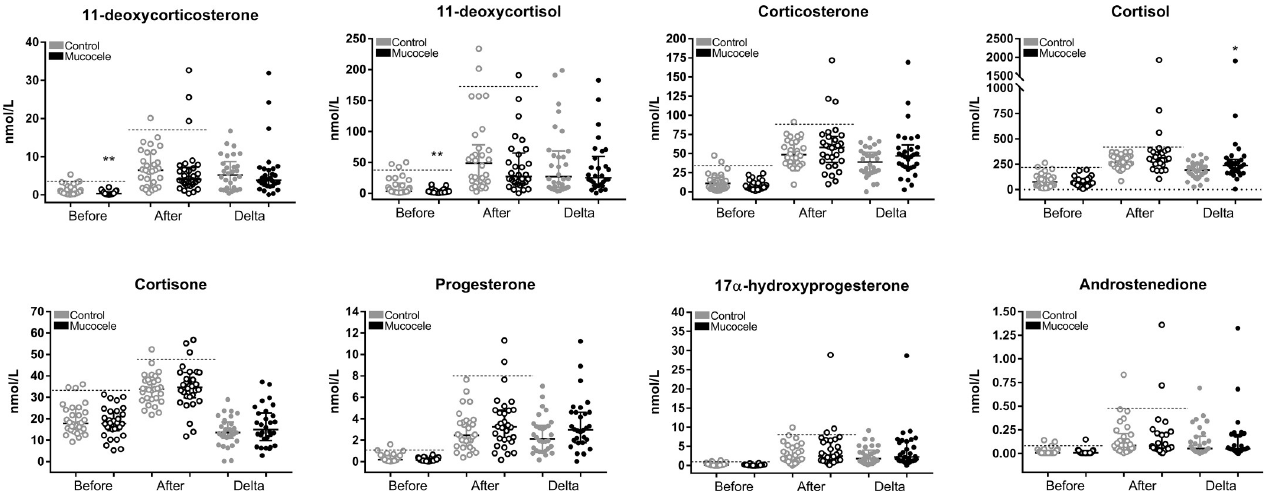
Fig 1. Measurements of serum steroid concentrations before and 1 hour after administration of cosyntropin to control dogs and dogs diagnosed with gallbladder mucocele formation. Data points represent individual dogs. Before and after refer to concentrations measured prior to and following administration of cosyntropin, respectively. Delta refers to the absolute change in steroid concentration after cosyntropin administration (after–before). Horizontal dashed lines indicate the upper limit of the reference interval established by CLSI C28-A3 Robust method using concentrations measured in control dogs in this study. Confidence interval (90%) for upper limit reference interval in control dogs is reported in S1 and S2 Tables. Bars represent median and interquartile range. � P < 0.05, �� P < 0.01 Wilcoxin signed rank test compared to control dogs under same conditions (Benjamini-Hochberg FDR � 0.15).